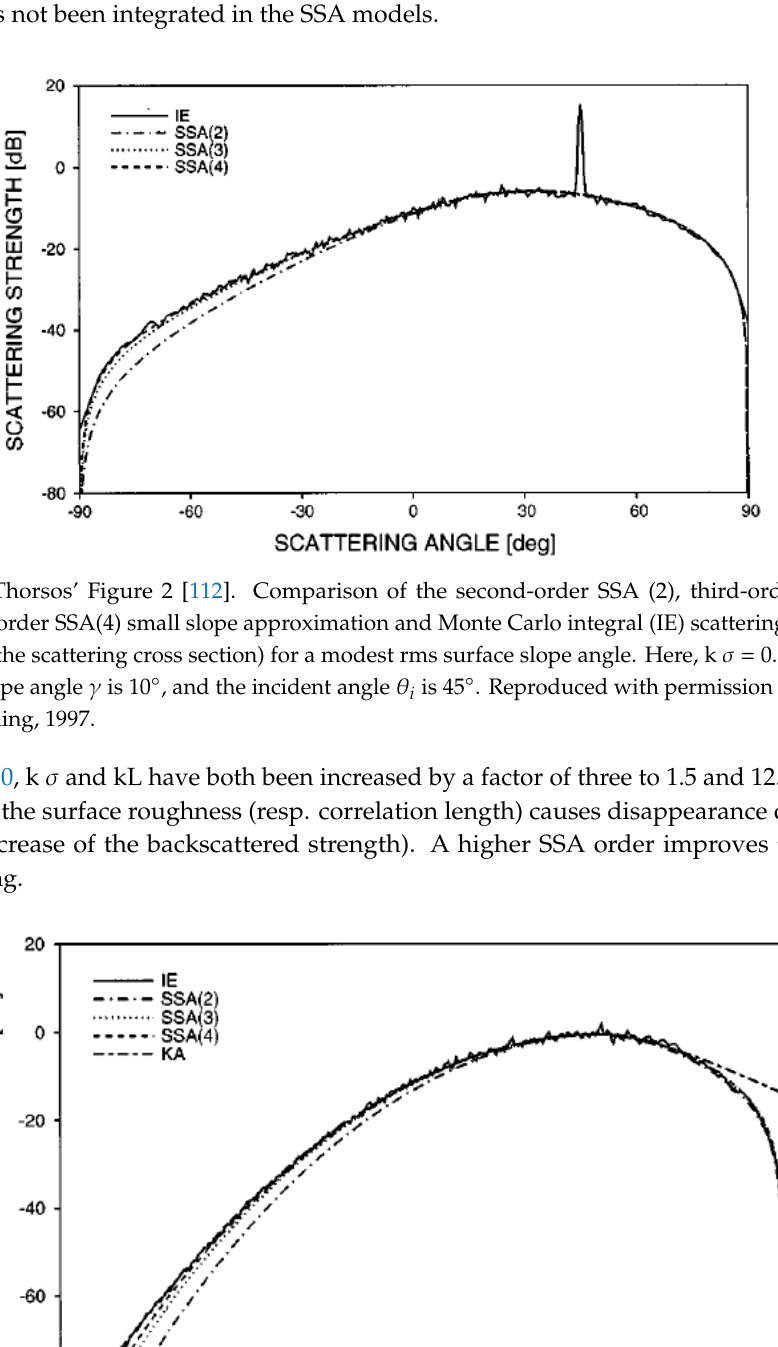
 is 45°. Reproduced with i